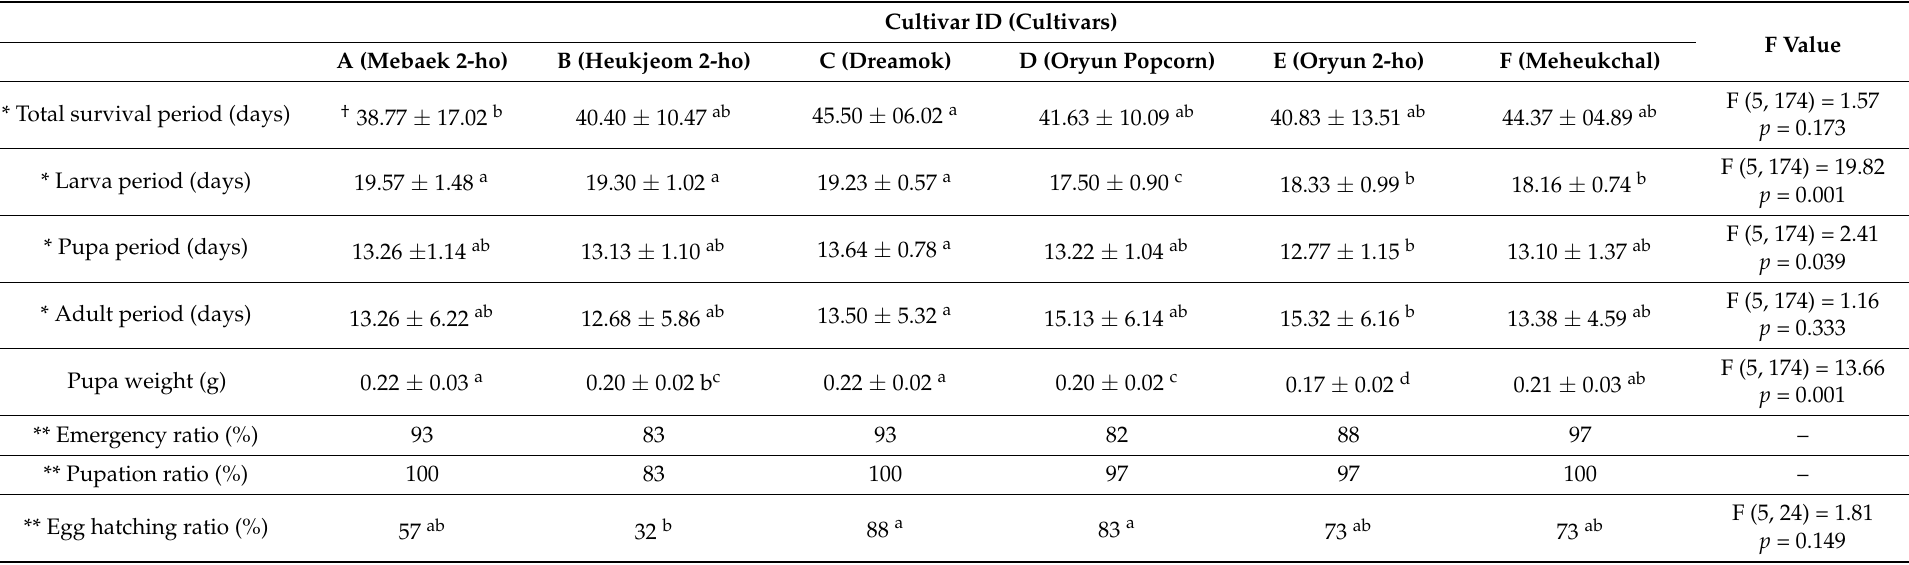
Table 1. Life table and comparison of growth characteristics based on selected maize ( Zea mays